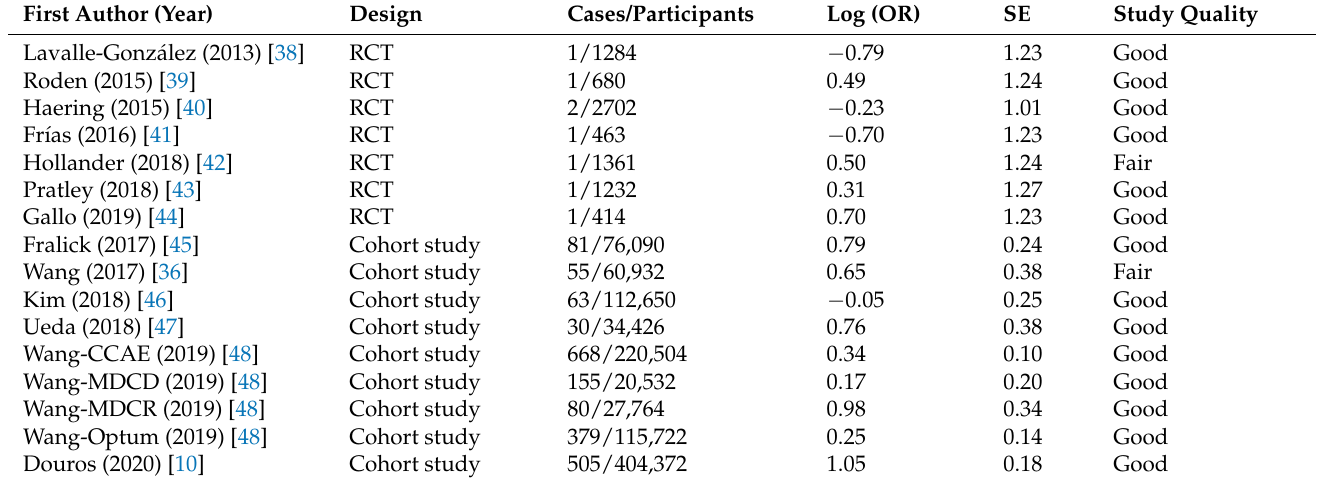
Table 2. Characteristics of studies included in the meta-analysis of the risk of diabetic ketoacidosis (DKA) among patients using sodium/glucose cotransporter 2 (SGLT-2) inhibitors compared with active